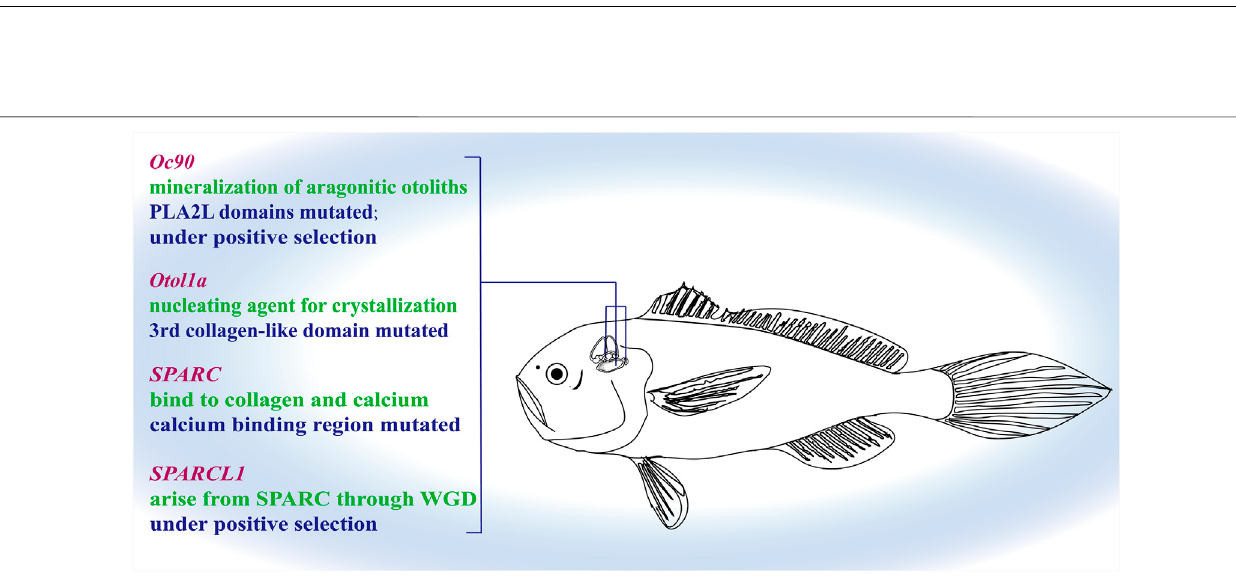
Frontiers in Genetics |